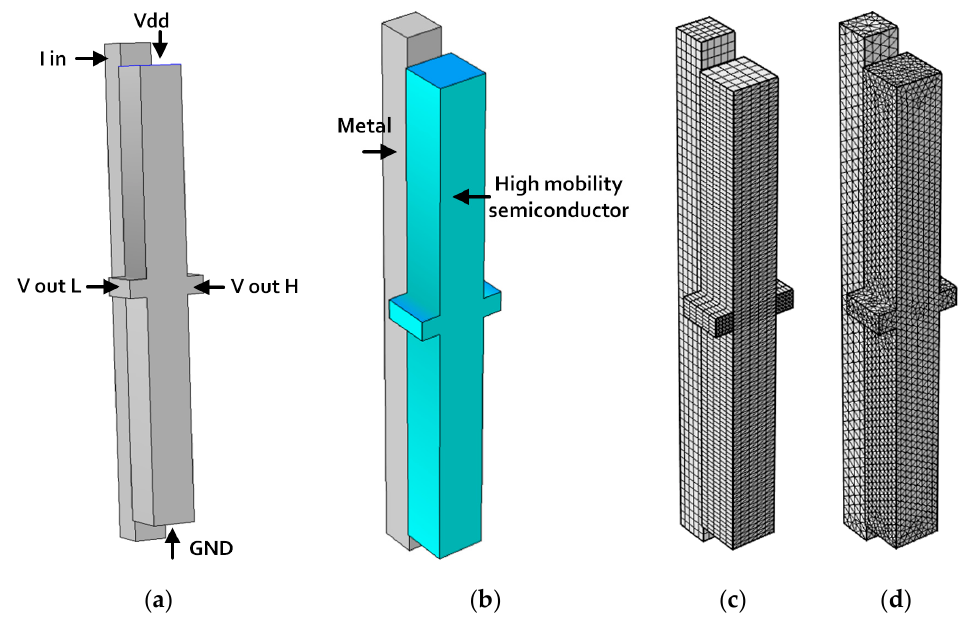
Figure 4. Design flow for a three-dimensional (3D) Hall Bar. ( a ) Preliminary design and definition of ports. ( b ) Layers definition. ( c ) Standard automatic mesh. ( d ) Adapted manual mesh with different density zones, used with tetrahedron default elements or extra-fine elements.